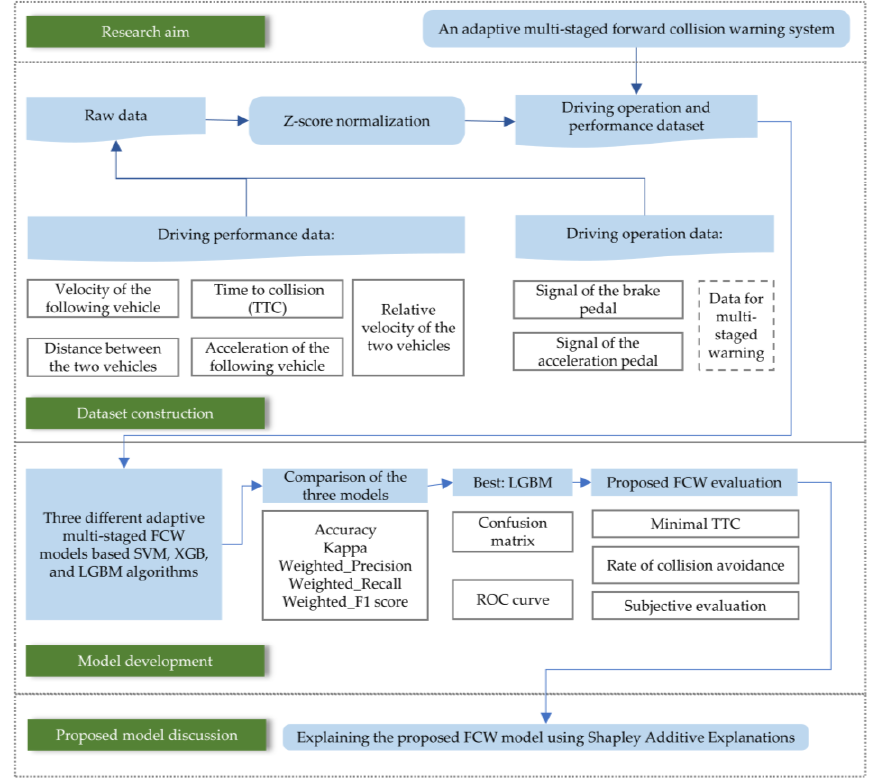
Figure 1. General framework.